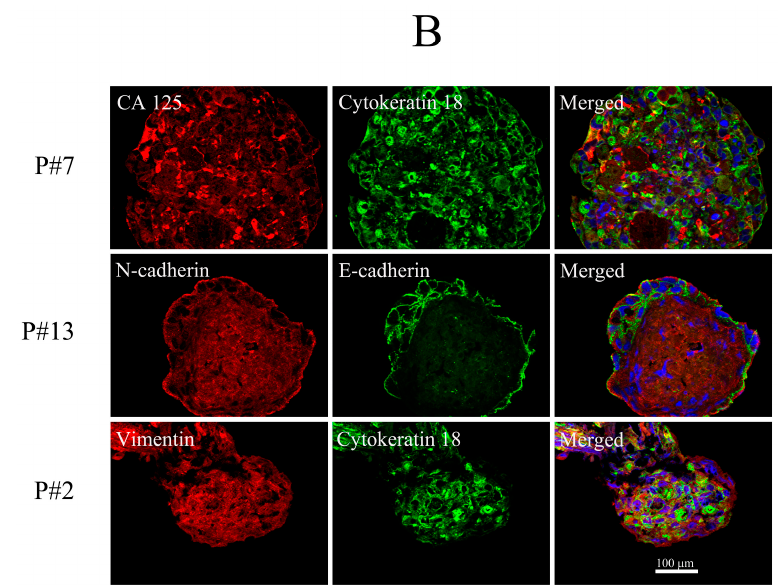
Figure 4. Morphological appearances of ascitic fluid-derived cells from selected patients are cultured in a cell monolayer and a 3D cell suspension. Cells cultured in the 3D cell suspension display three distinct patterns consisting of compacted spheroids, small clusters and loose single cells ( A ). Ascitic fluid derived cells from selected patients cultured in a 3D cell suspension positively express CA125, cytokeratin-18, N-cadherin, E-cadherin and vimentin ( B ).